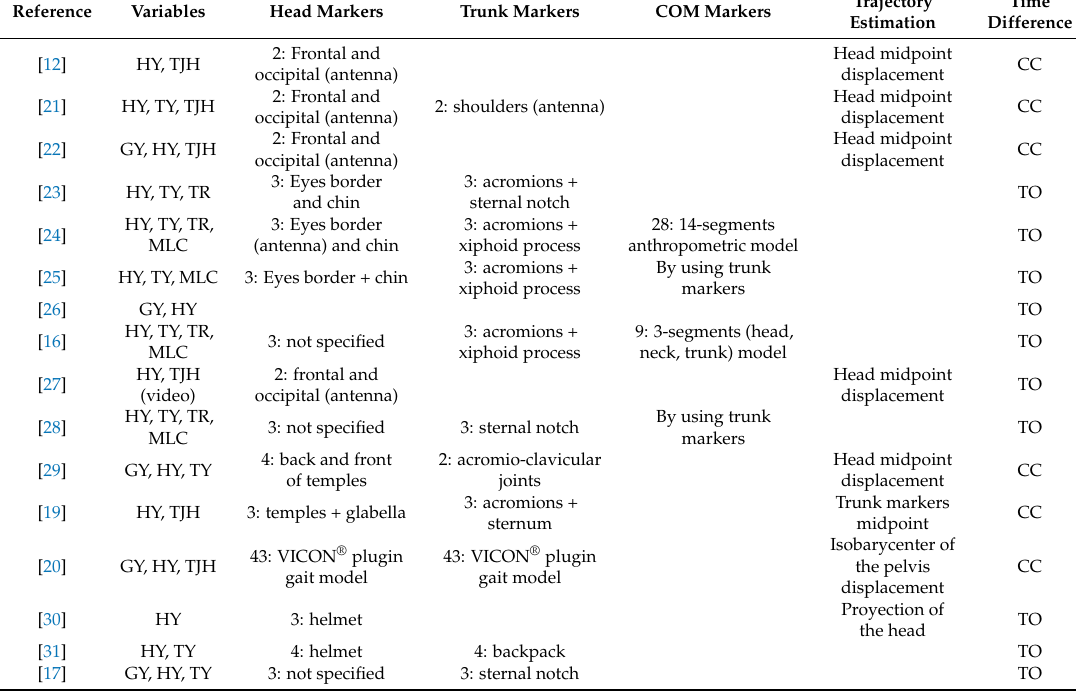
Table 1. Kinematical variables and estimation details in the studies based on optical motion capture and Body Center Of Mass Medio-Lateral Displacement